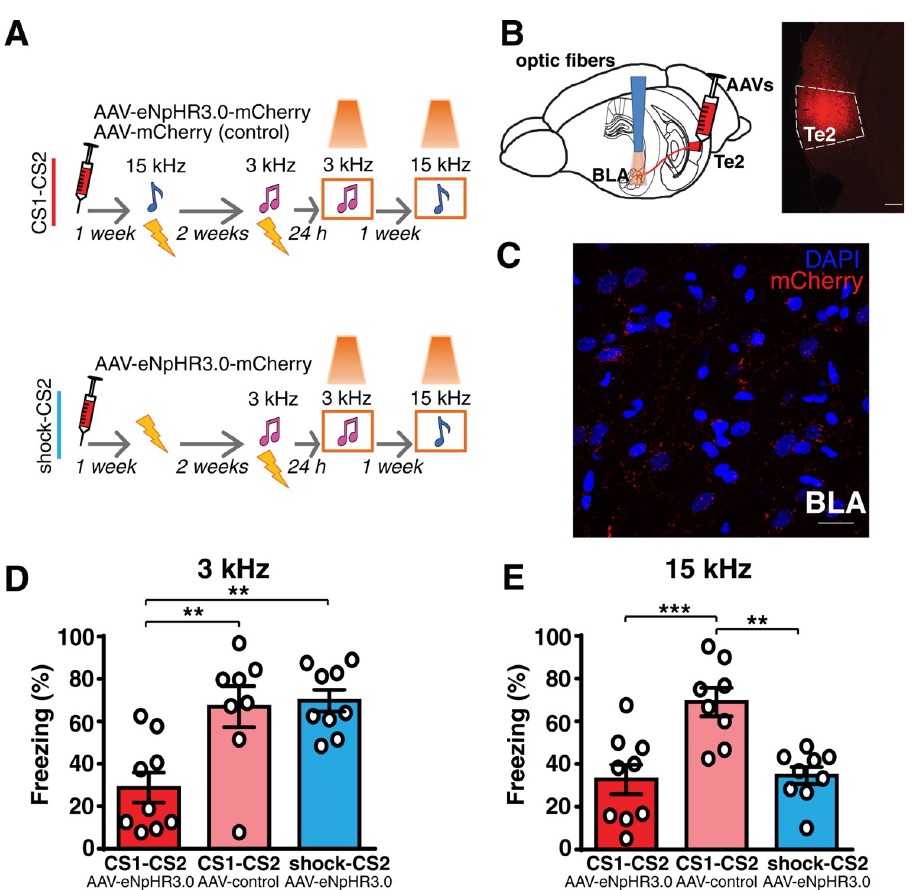
Fig 3. Prior auditory fear learning makes the Te2-to-BLA pathway necessary for the retention of new recent memories. (A and B) The Te2 was injected with rAAV5/CamKIIa-eNpHR3.0-mCherry-WPRE or rAAV5/CamKIIa- mCherry-WPRE. Optic fibers were implanted above the BLA in order to manipulate Te2 axons terminals within the BLA. (C) Representative micrograph showing the expression of AAV-mCherry in Te2 and its terminals in the BLA. Scale bars, 300 and 20 μ m, respectively. (D) Optogenetic inhibition of Te2 axon terminals in BLA affected the retention of recent fear memory only in animals that had been trained in another CS-US association (1-way ANOVA, F (2,23) = 9.85, p = 0.0008, η 2 = 0.4614; Tukey: CS1-CS2 eNpHR3.0-mCherry n = 9 vs. CS1-CS2 control-mCherry n = 8, p = 0.0040; CS1-CS2 eNpHR3.0-mCherry vs. shock-CS2 eNpHR3.0-mCherry n = 9, p = 0.0016; CS1-CS2 control-mCherry vs. shock-CS2 eNpHR3.0-mCherry , p = 0.962). (E) Freezing to the tone of 15 kHz was similar between rats in which it had previously been paired to the US (remote fear memory) and in rats that had never been exposed to this tone while it was higher in rats injected with the control vector (1-way ANOVA, F (2,23) = 11.29, p = 0.0004, η 2 = 0.4953; Tukey: CS1-CS2 eNpHR3.0-mCherry vs. CS1-CS2 control-mCherry , p = 0.0008; CS1-CS2 eNpHR3.0-mCherry vs. shock-CS2 eNpHR3.0-mCherry , p = 0.972; CS1-CS2 control-mCherry vs. shock-CS2 eNpHR3.0-mCherry , p = 0.0014), thus suggesting that optogenetic inhibition of the Te2-to-BLA pathway also affected the retention of remote memory. �� P < 0.01, ��� P < 0.001. All data are mean and SEM. The summary data for Fig 3 can be found in Supporting information in the file named S3 Data. BLA, basolateral amygdala; CS, conditioned stimuli; US, unconditioned stimulus.